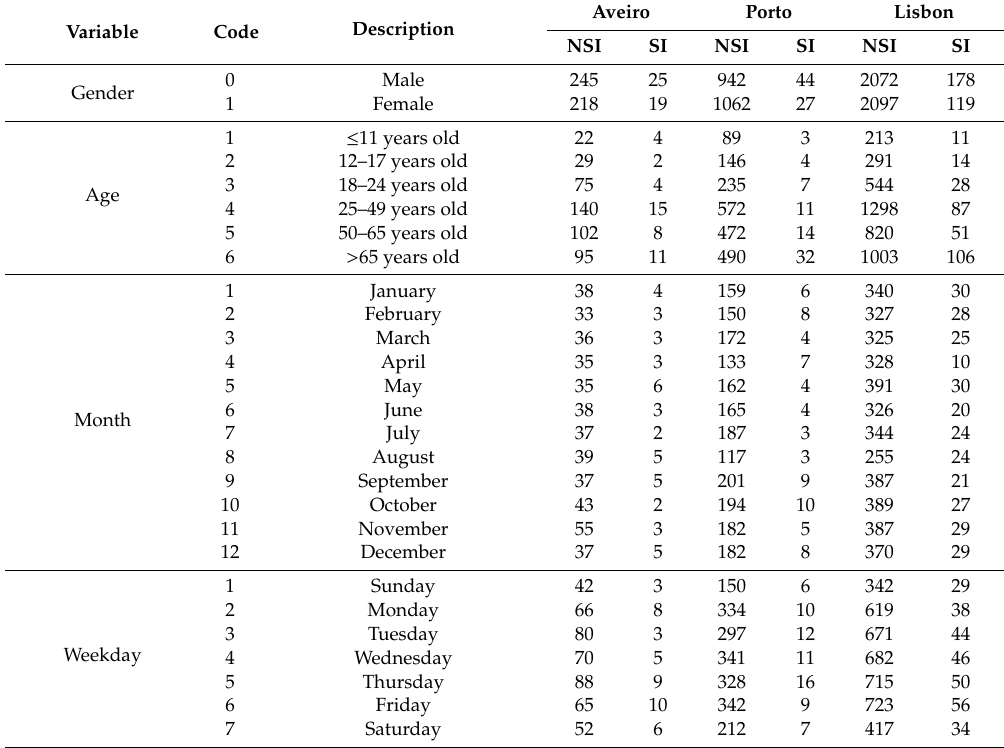
Table 1. Description of the variables and number of reported injuries classified by severity.